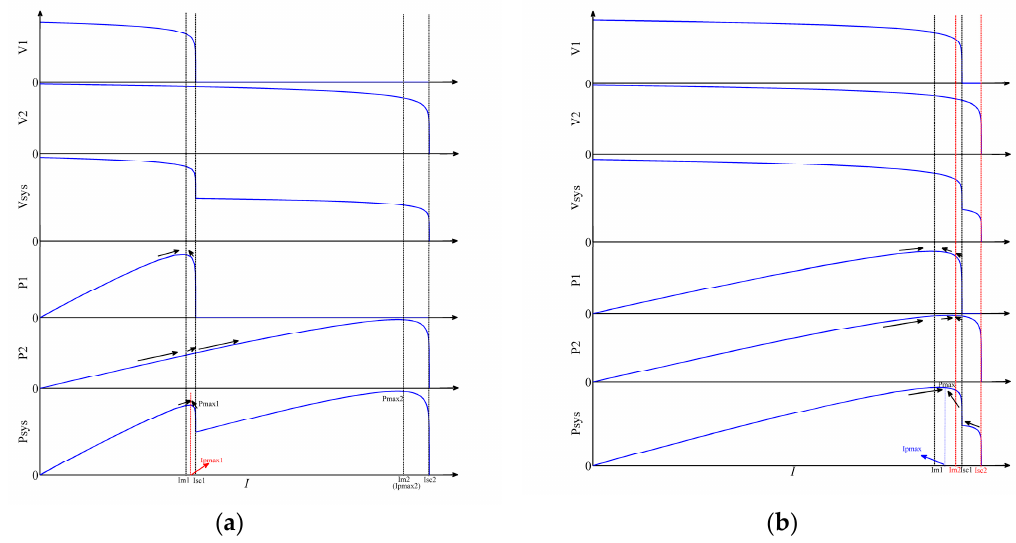
Figure 3. Dynamic characteristic curves of 2 PV arrays series connected in different condition; ( a )